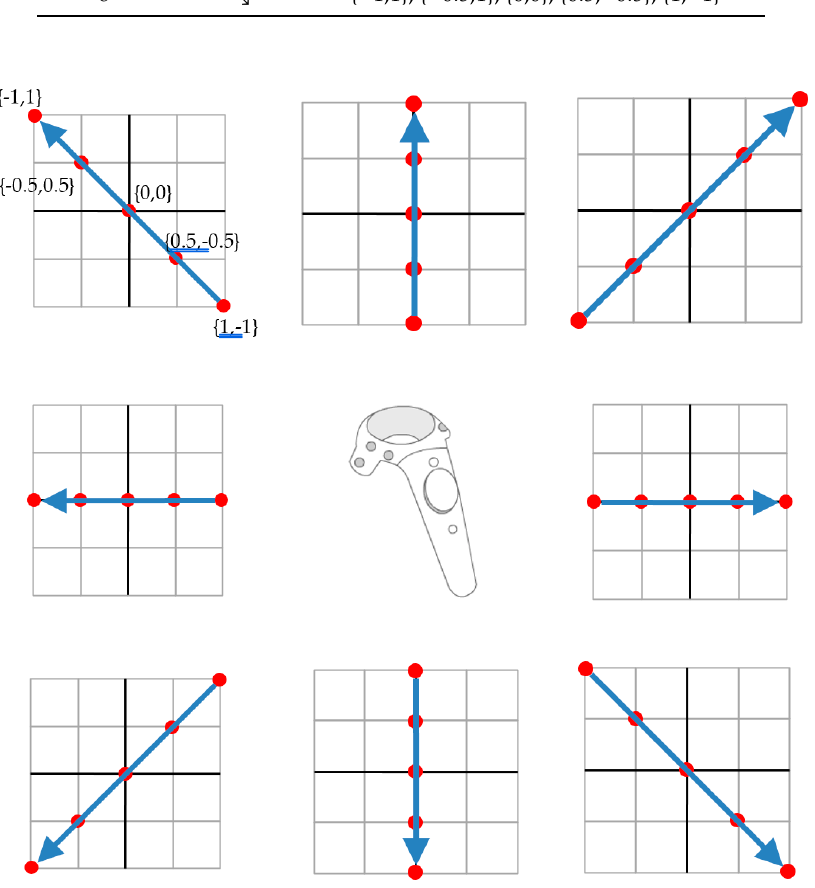
Figure 8. Eight recognition targets.